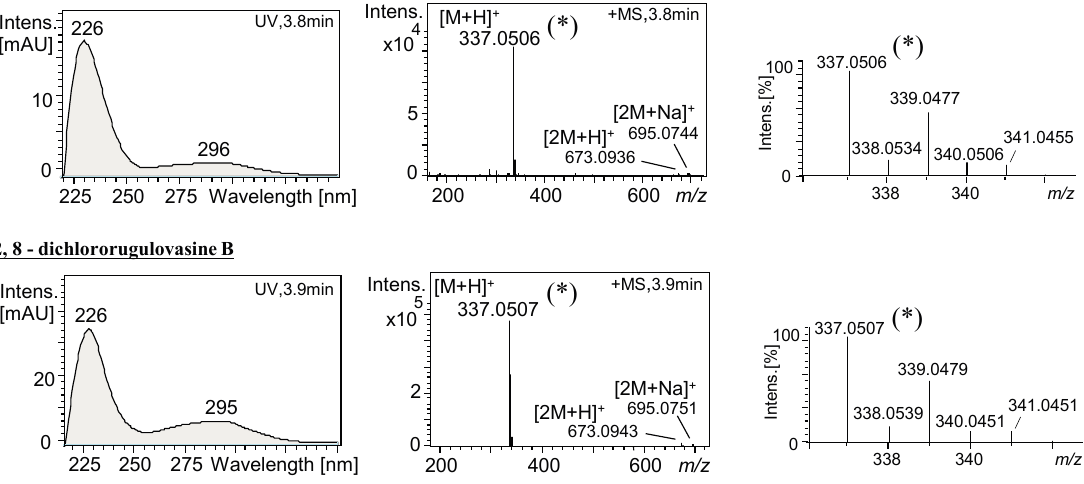
Figure 3. UV/Vis and full scan spectra of 2,8-dichlororugulovasine A and B produced by T. wortmannii in PDA incubation medium. (*) Magnified signal from pseudomolecular ion [M + H] + and corresponding isotopes. Data acquired at ESI+, UHPLC-DAD-QTOFMS